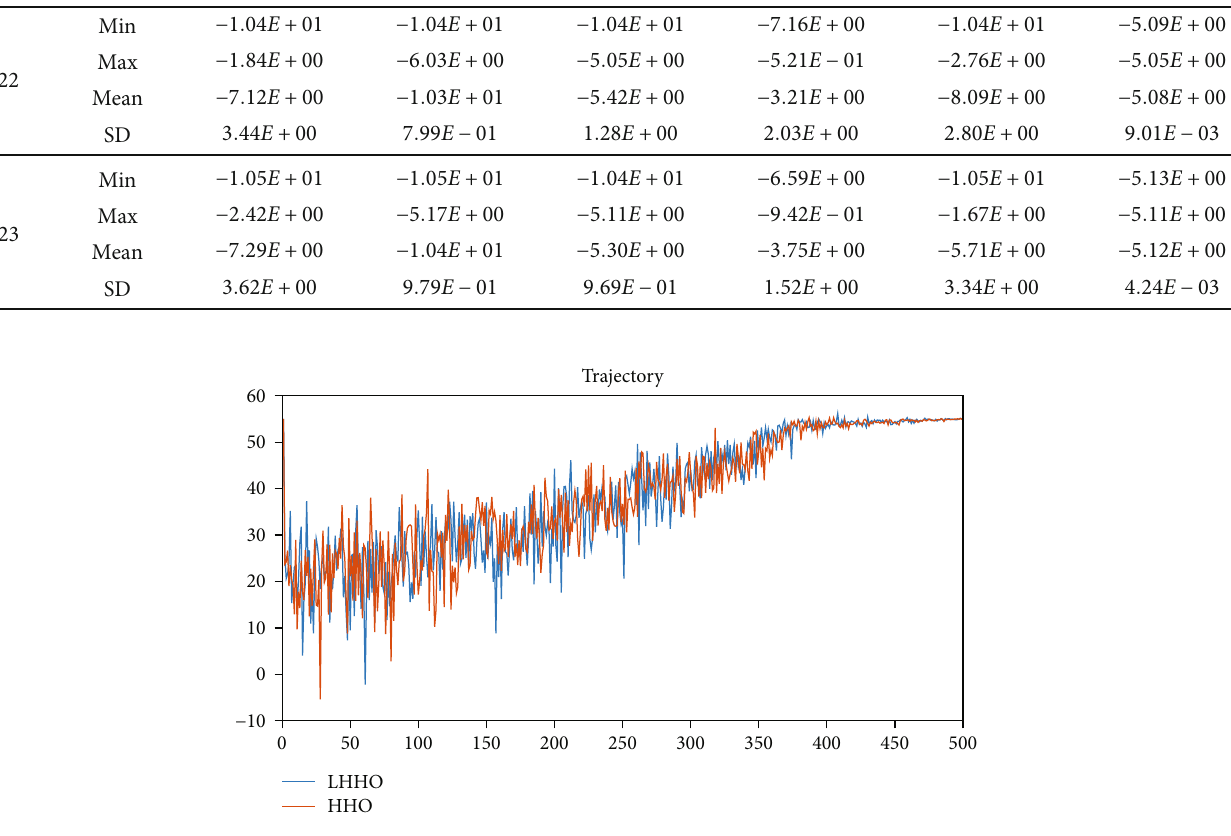
Figure 9: Trajectory of LHHO and HHO for biodiesel function. Table 4: Statistical attributes of objective function values in the maximization